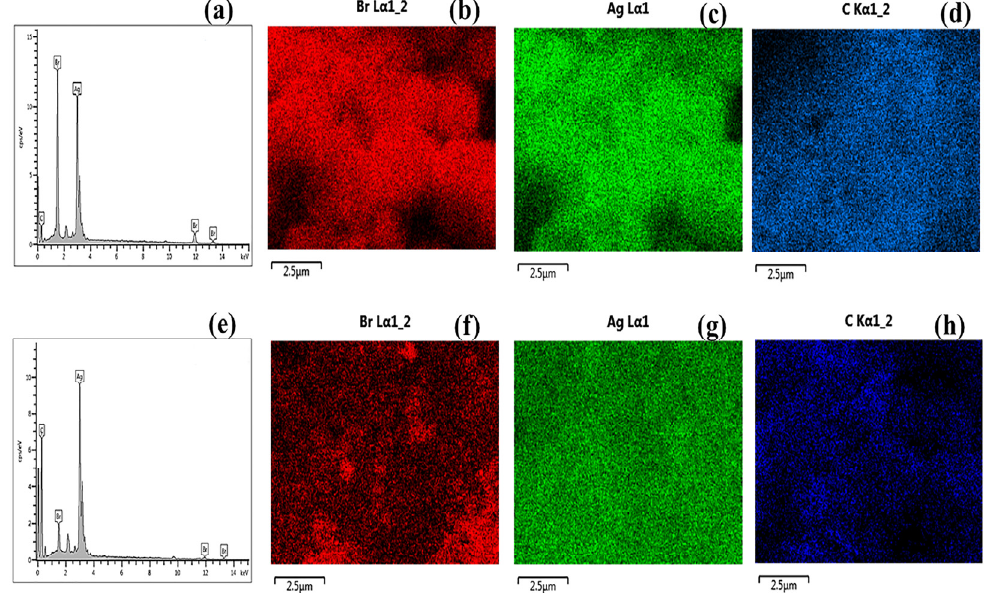
Figure 3. EDX spectrum and elemental mapping of TP-AABR-ACK ( a – d ) and DP-AABR-ACK ( e – h ).